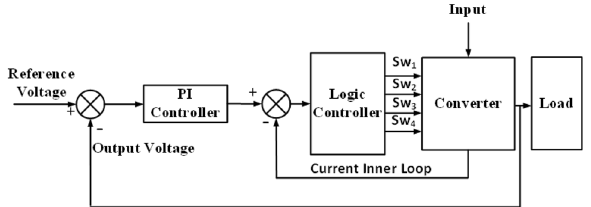
Figure 7. Implementation block diagram.